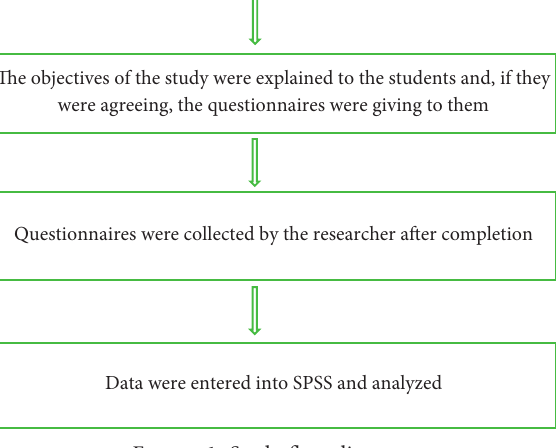
Figure 1: Study flow